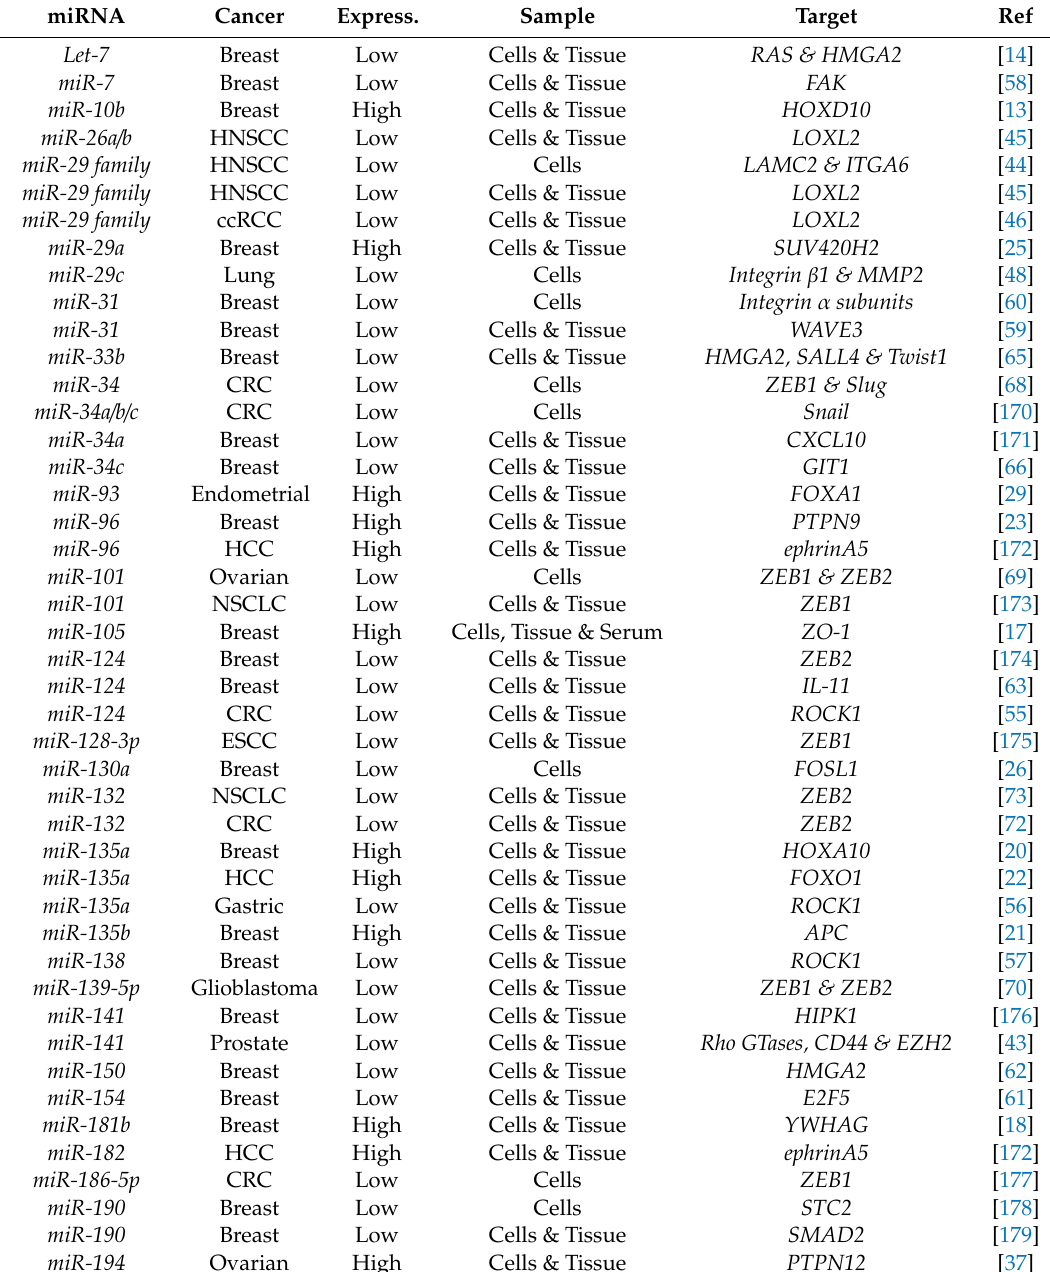
Table 1. List of miRNAs associated with